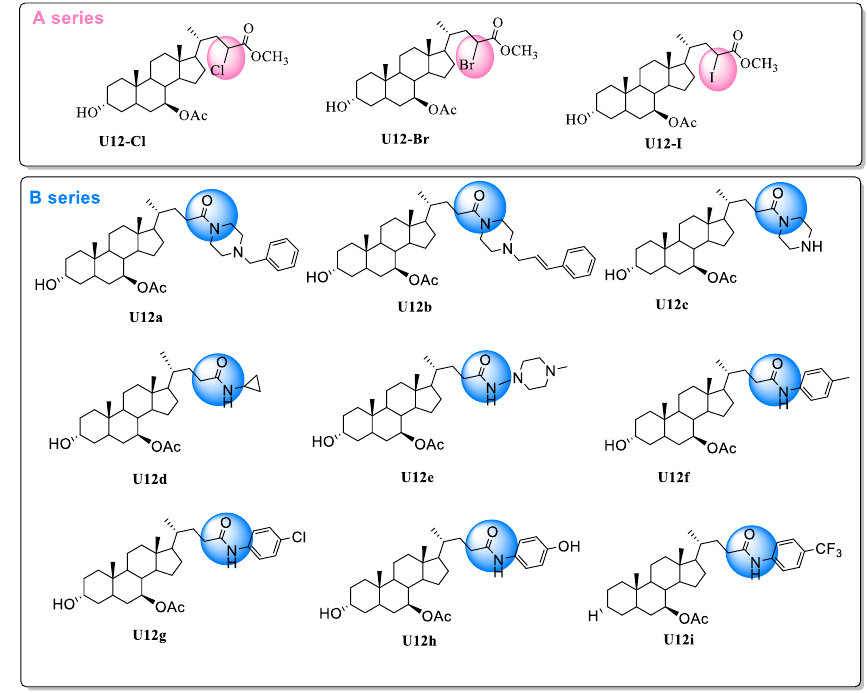
Figure 1. U12 derivatives of two series ( A , B ).